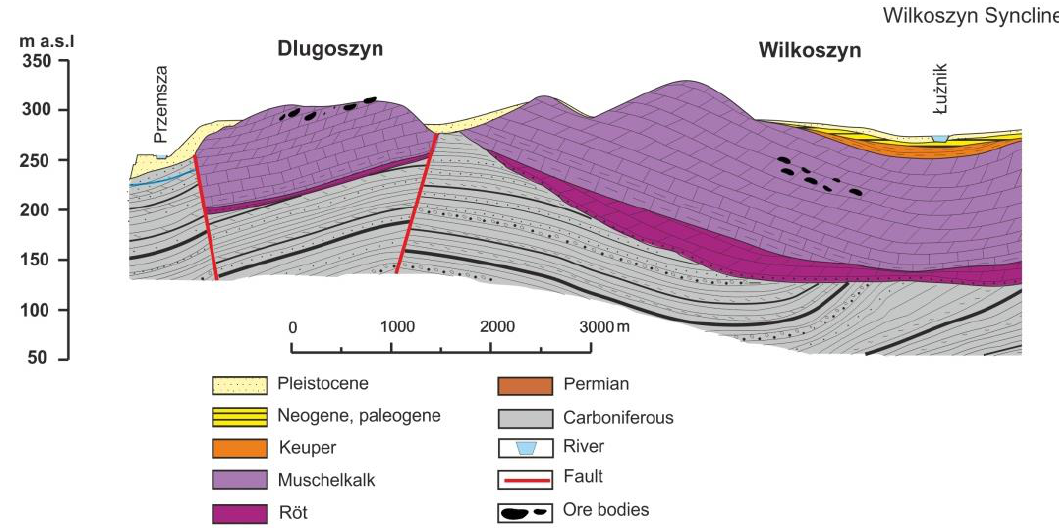
Figure 1. Schematic geological cross-section of the study area showing location of ore bodies, without Quaternary sediments (after [54]).